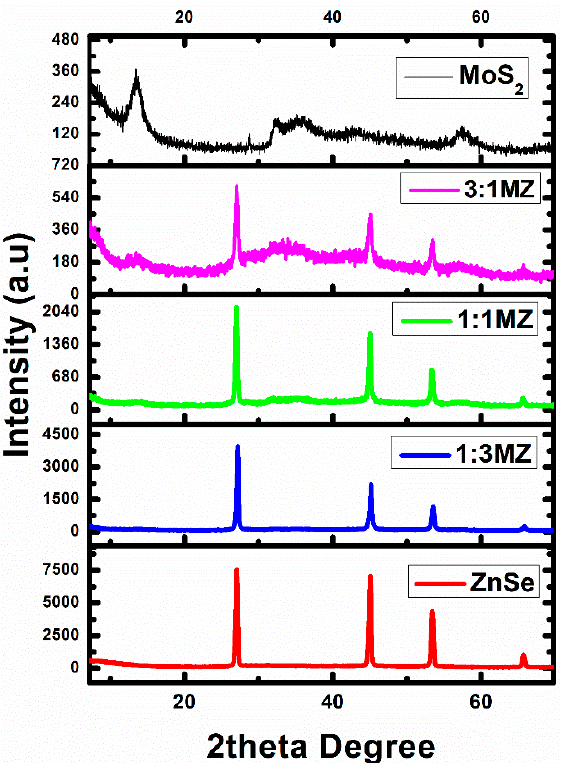
Figure 1. X-ray diffraction spectra of MoS 2 , ZnSe and their heterostructures. Figure 1. X-ray di ff raction spectra of MoS 2 , ZnSe and their